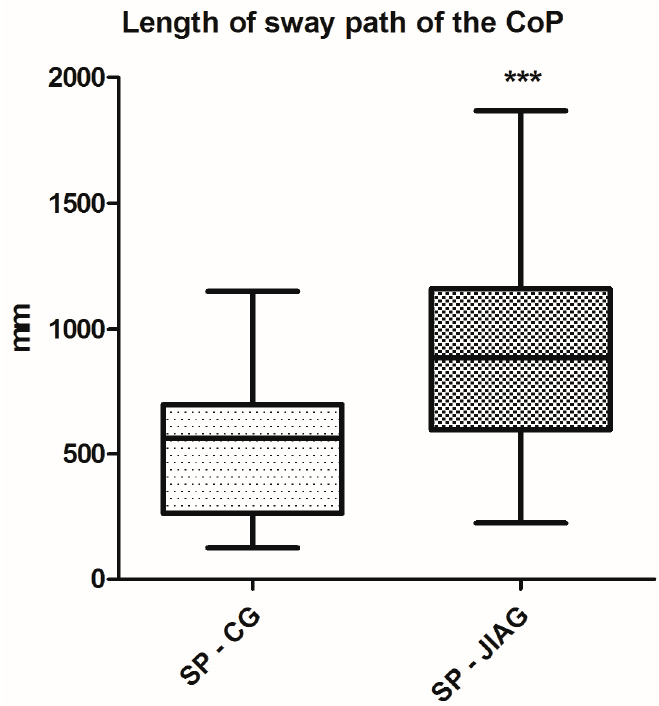
Figure 1. Analysis of length of sway path (SP) of the centre of pressure (CoP) among the group of healthy subjects (CG) and subjects with juvenile idiopathic arthritis (JIAG). *** indicated that p < 0.0001